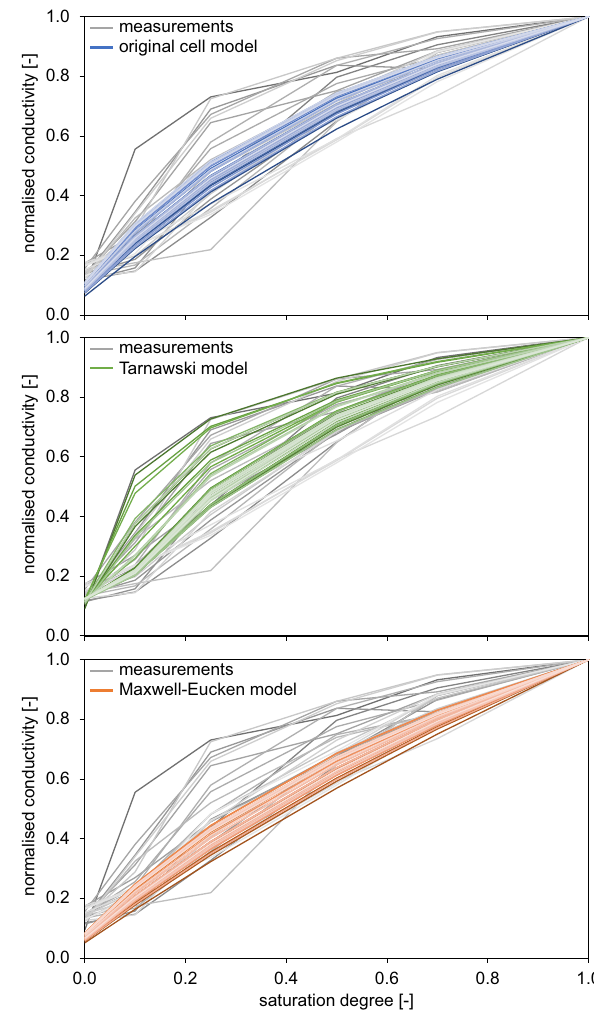
Fig. 2 Comparison of effective soil thermal conductivity estima- tions by original cell model, Tarnawski model and Maxwell-Eucken model (see Sect. 4 for the relevant discussion of the latter), in con- frontation with measured